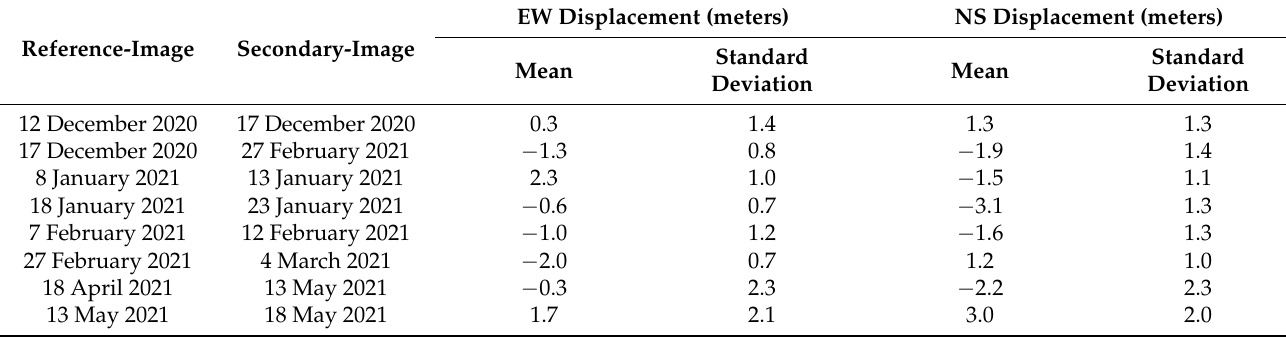
Table 2. The mean and standard deviation of the displacements of the stable regions in the Sentinel-2A/B image pairs. Each value is calculated by averaging the five